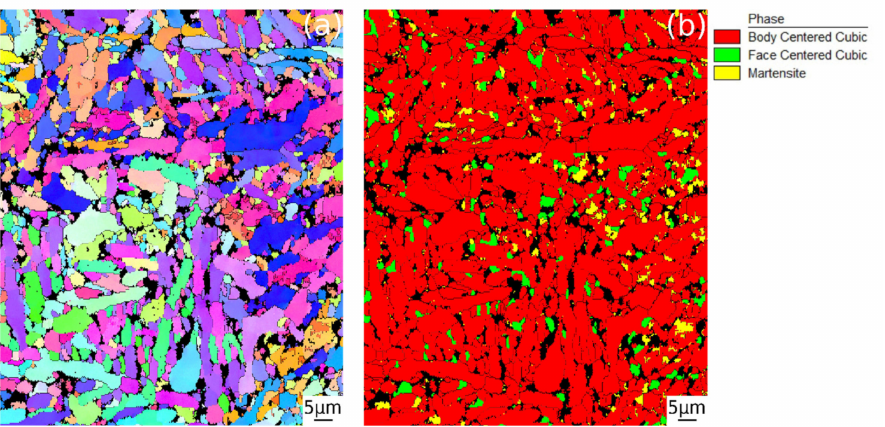
Figure 12. Detailed inverse pole ( a ) figure and phase identification of the material subjected to austempering treatment ( b